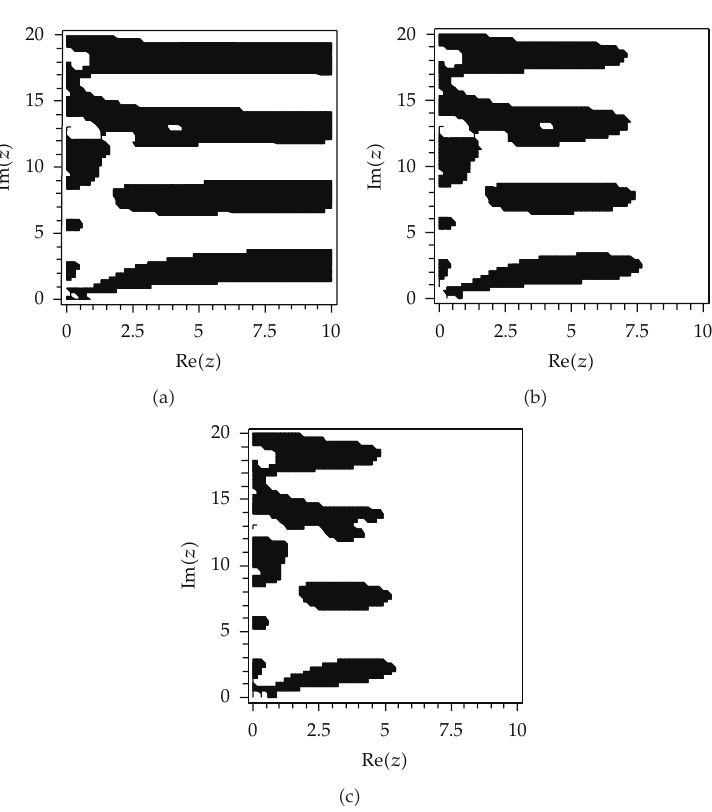
Figure 1: Stability region of the exponentially fitted method which is based on the higher-order formula of EHM6 (cid:3) 4 (cid:4) method. (cid:3) a (cid:4) (cid:3) H (cid:6) 0 . 1, z ∈ C (cid:4) , (cid:3) b (cid:4) (cid:3) H (cid:6) 0 . 5, z ∈ C (cid:4) , (cid:3) c (cid:4) (cid:3) H (cid:6) 1, z ∈ C (cid:4)